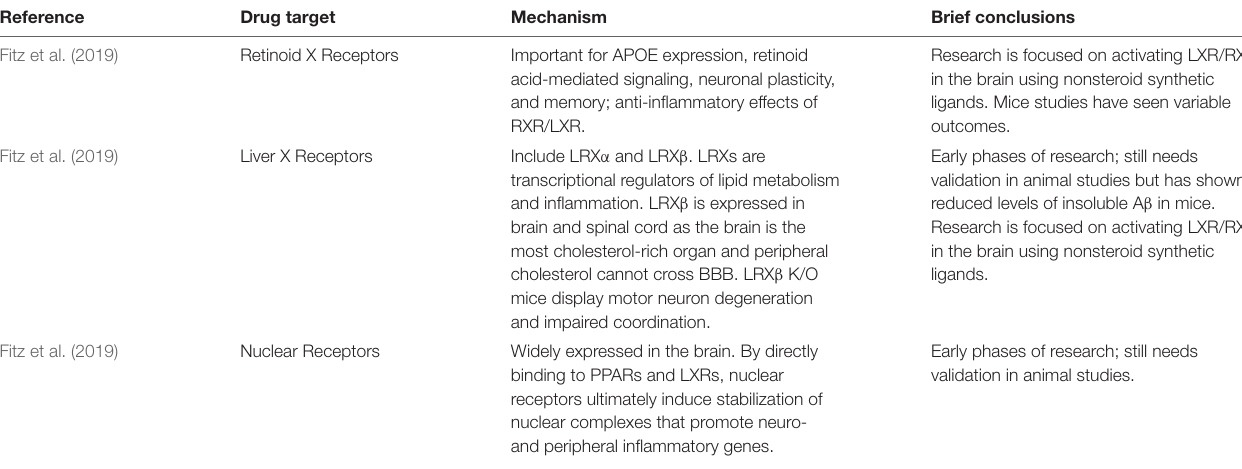
TABLE 4 | Major non-anti-amyloid AD treatments under